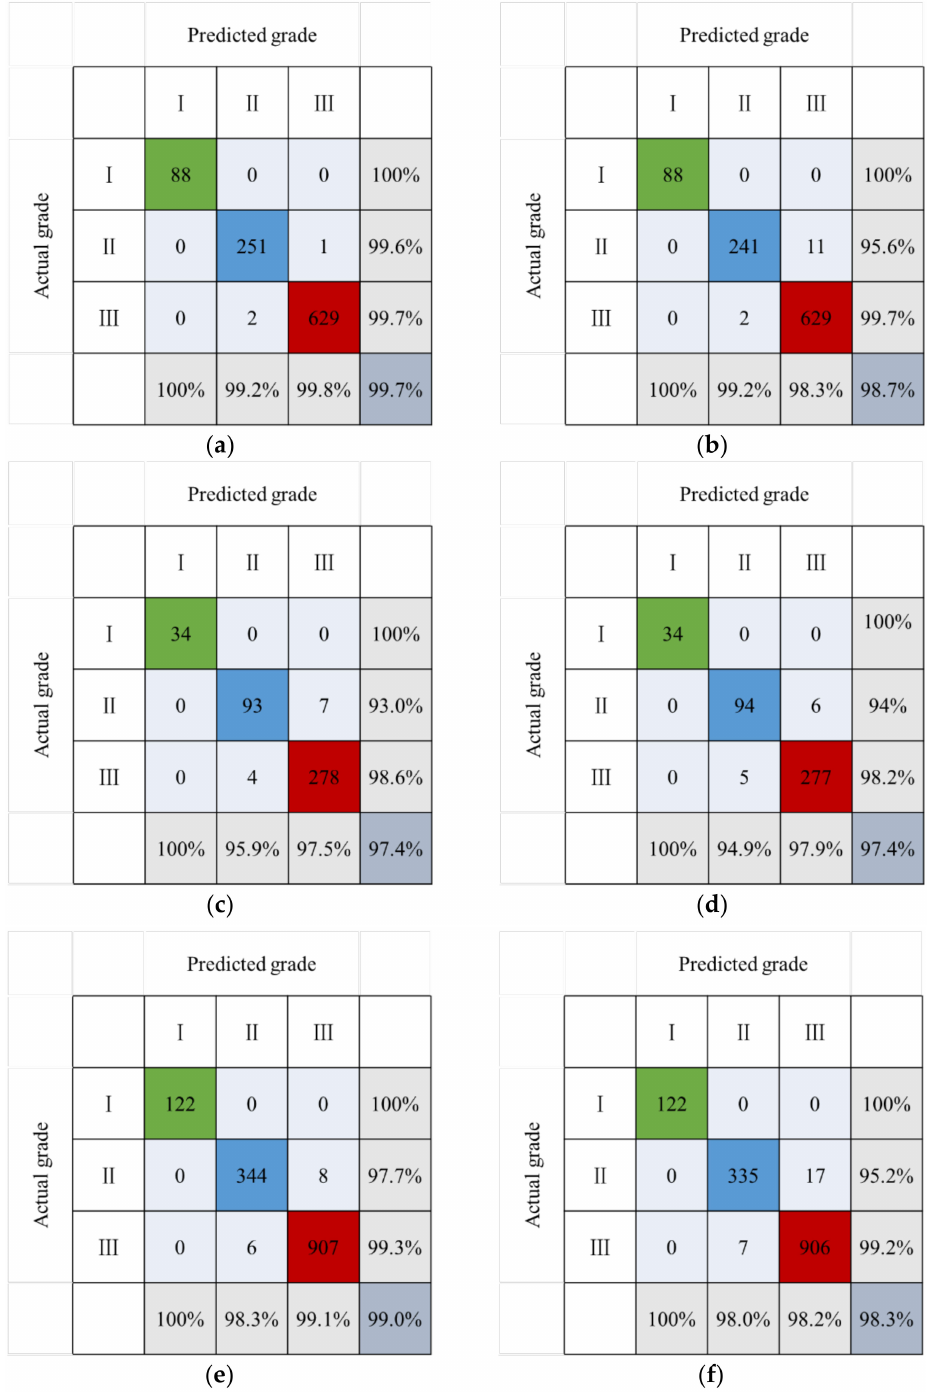
Figure 4. Confusion matrices of optimization models based on machine learning: ( a ) Training samples- RF; ( b ) Training samples-SVM; ( c ) Test samples-RF; ( d ) Test samples-SVM; ( e ) Total samples-RF; ( f ) Total